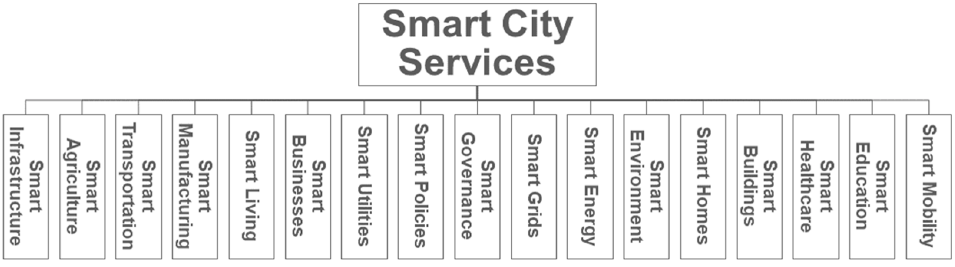
Figure 2. Smart city services.